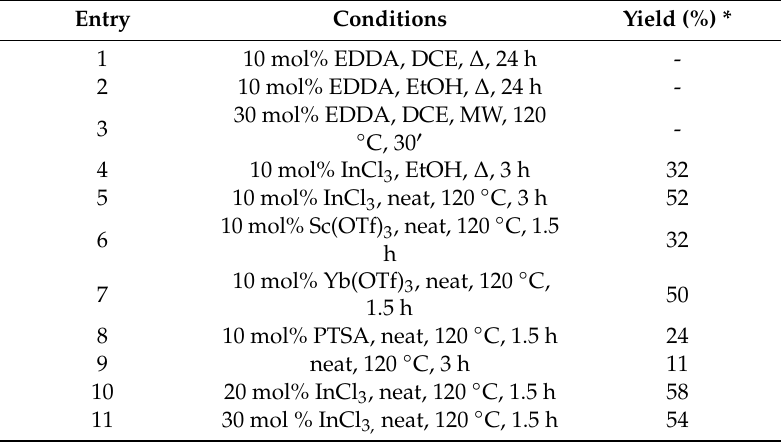
Table 1. Optimization of the MCR of 1 , 2 and